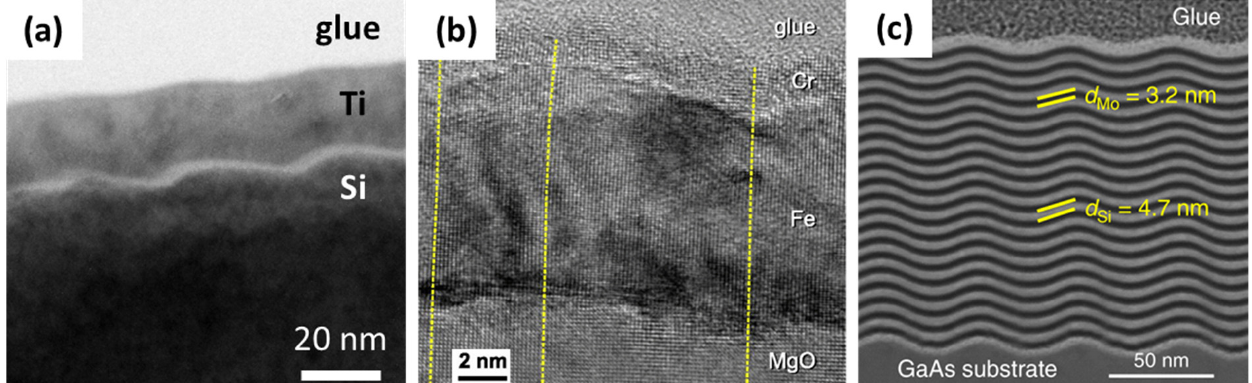
Figure 3. Cross-sectional transmission electron microscopy (TEM) images of thin films grown on nanorippled substrates. ( a ) Polycrystalline Ti film grown on a nanorippled Si substrate with native surface oxide. Reprinted from Ref. [98] with permission from Elsevier. ( b ) Epitaxially grown, single-crystalline Fe film on a nanorippled, crystalline MgO surface. Reprinted from Ref. [94], with the permission of AIP Publishing. ( c ) Mo-Si multilayer stack grown on a nanorippled GaAs substrate. Reproduced from Ref. [27].